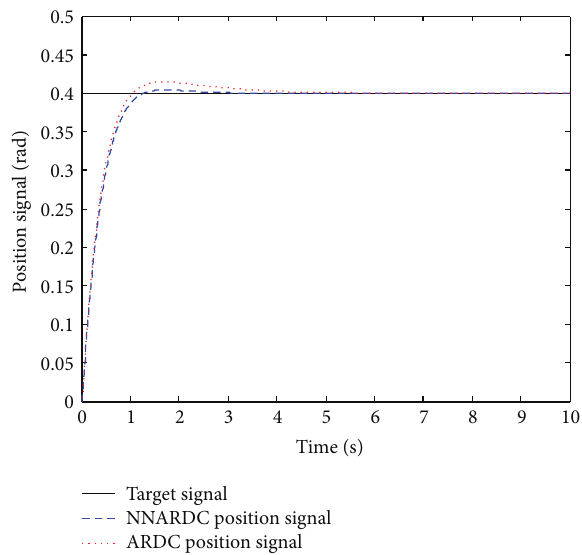
Figure 5: ARDC and NNARDC positioning results with 30% change of 𝐽